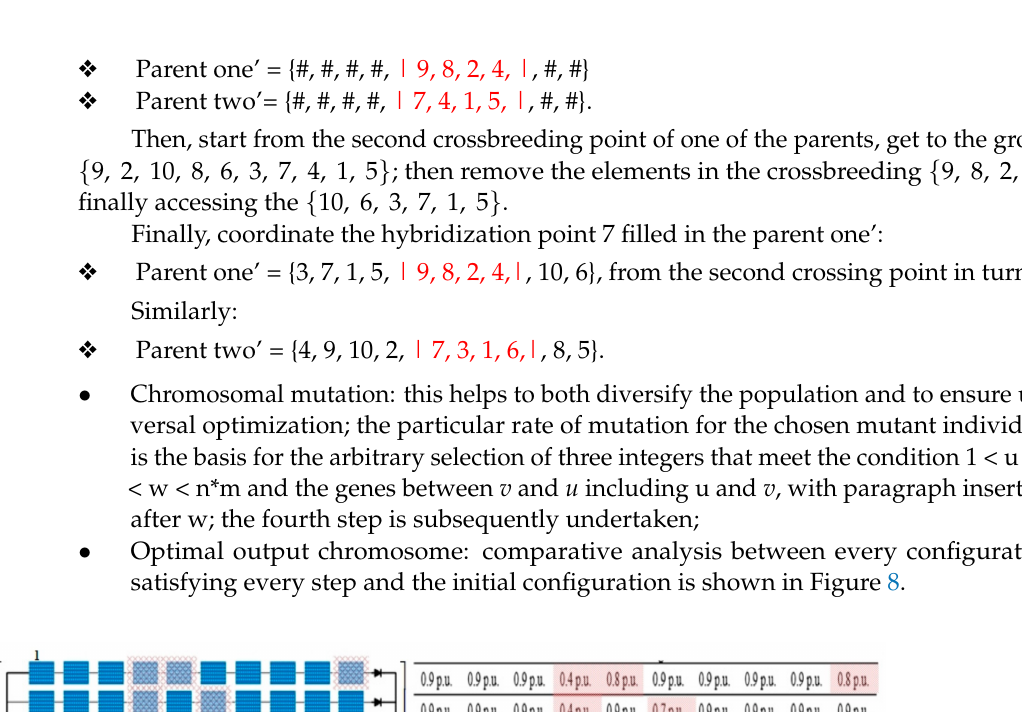
smallest number of swap times and the highest amount of output power. Python